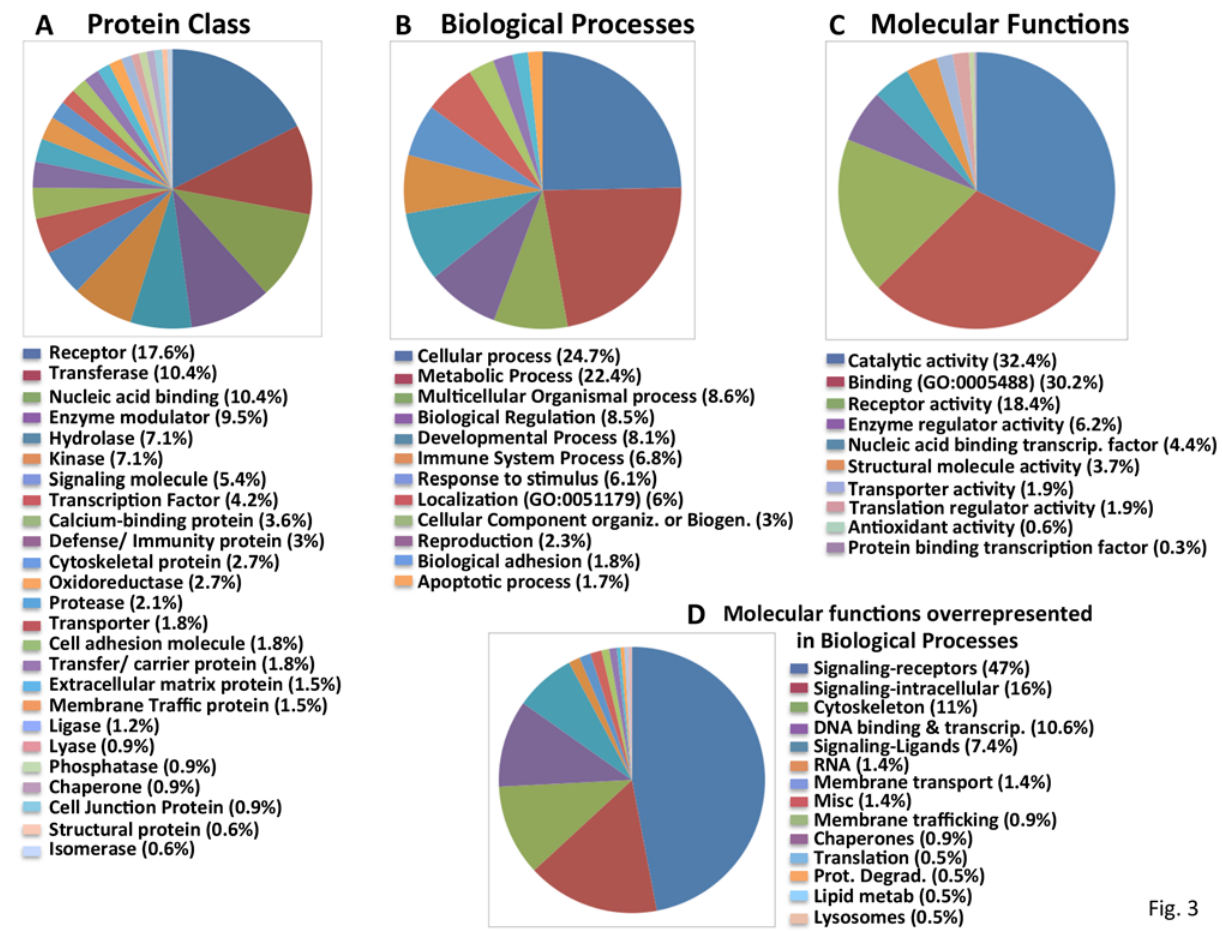
Fig 3. Classification of the “ Confirmed S6-P positives ” into functional groups. Categorization of “ Confirmed S6-P positives ” using the PANTHER classification system into A. Protein Class; B. Molecular Function; C. Biological Processes. D. Manual reclassification by molecular function of the non- redundant “ Confirmed S6-P positives ” (listed in Supp Table 7) comprising the subcategories of “ Biological Processes overrepresented in comparison to the whole genome (shown in S1 Fig.).